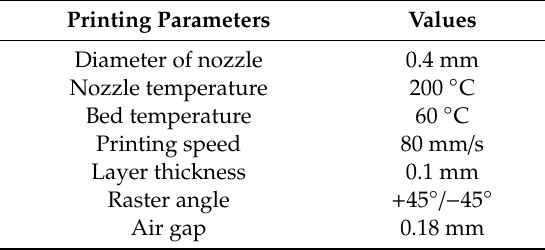
Table 1. Parameters of 3D